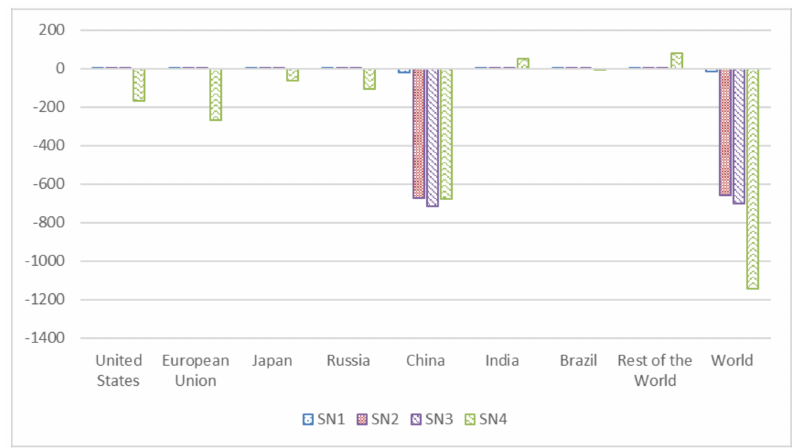
Figure 4. CO 2 emissions from fossil fuels: Deviations from BAU. Mt CO 2 . Source: The